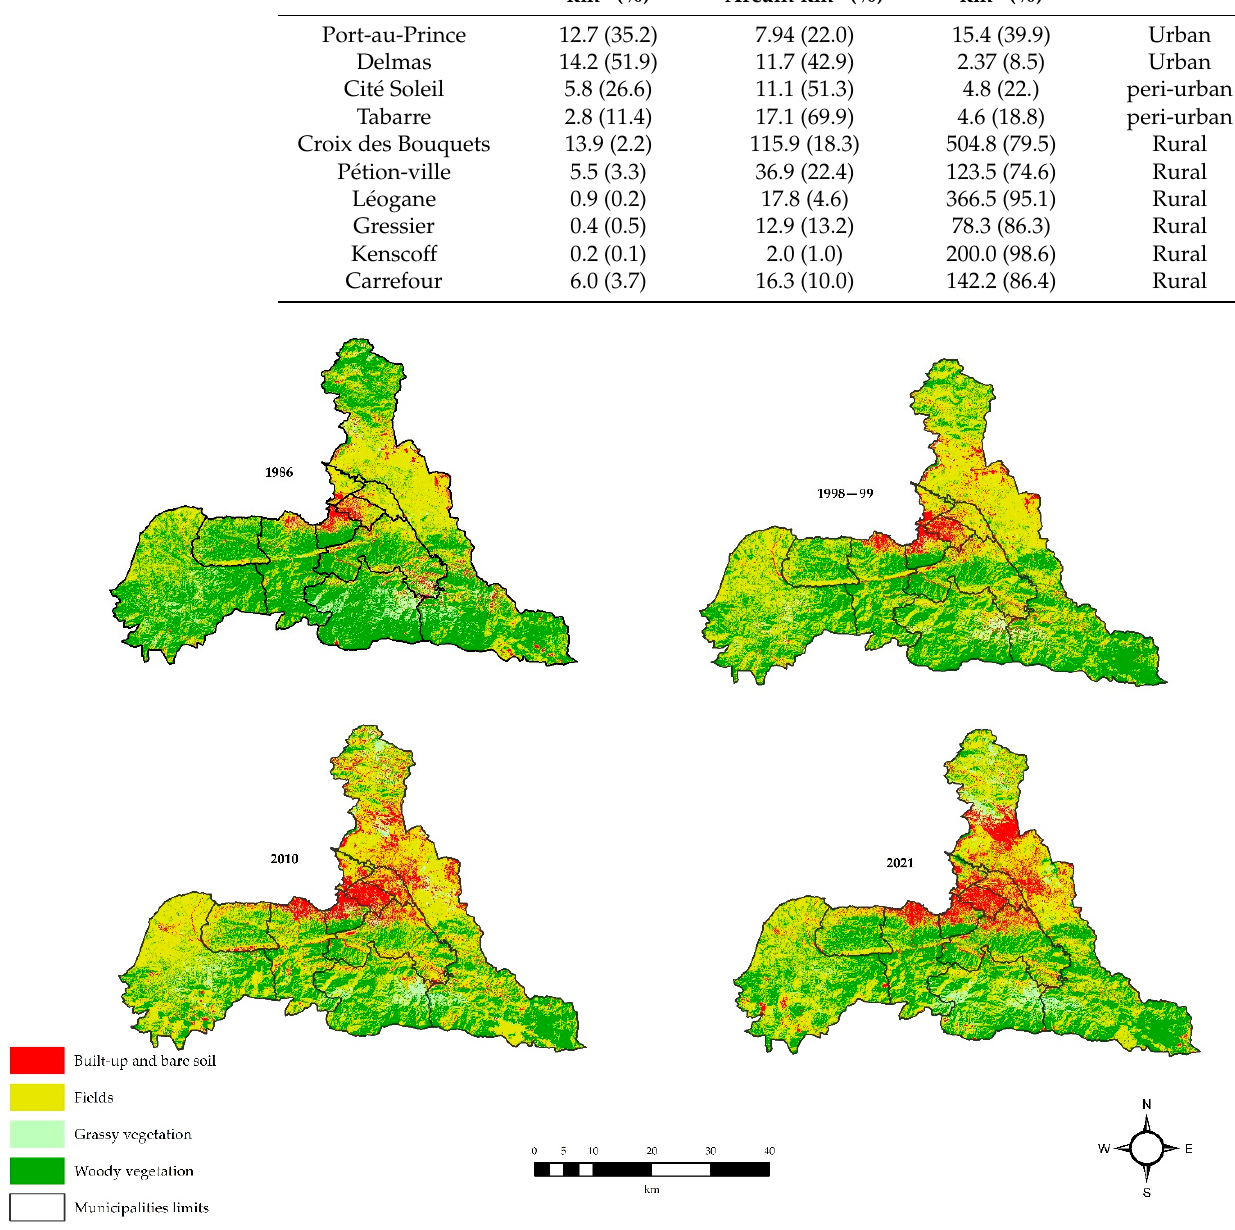
Figure 3. Land cover maps of the Port-au-Prince agglomeration from supervised classification of Landsat image mosaics from 1986, 1998–1999, 2010 and 2021 based on the maximum likelihood algorithm. The black lines correspond to the boundaries of the municipalities.